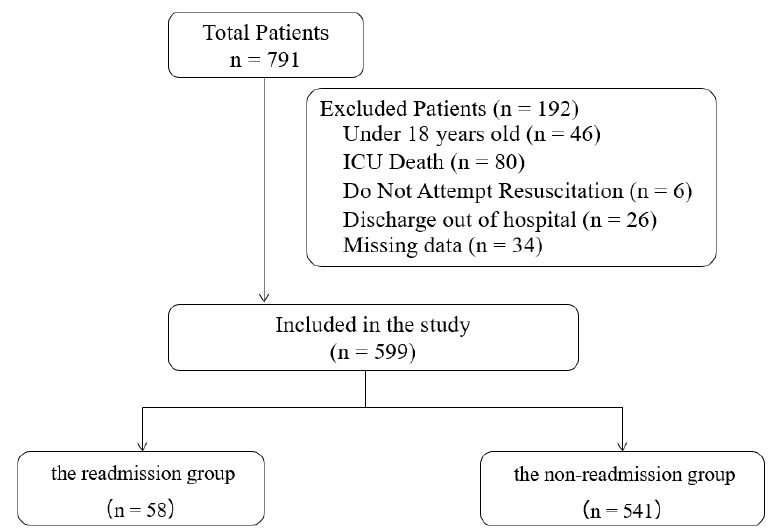
Figure 1. Patient enrolment flowchart.